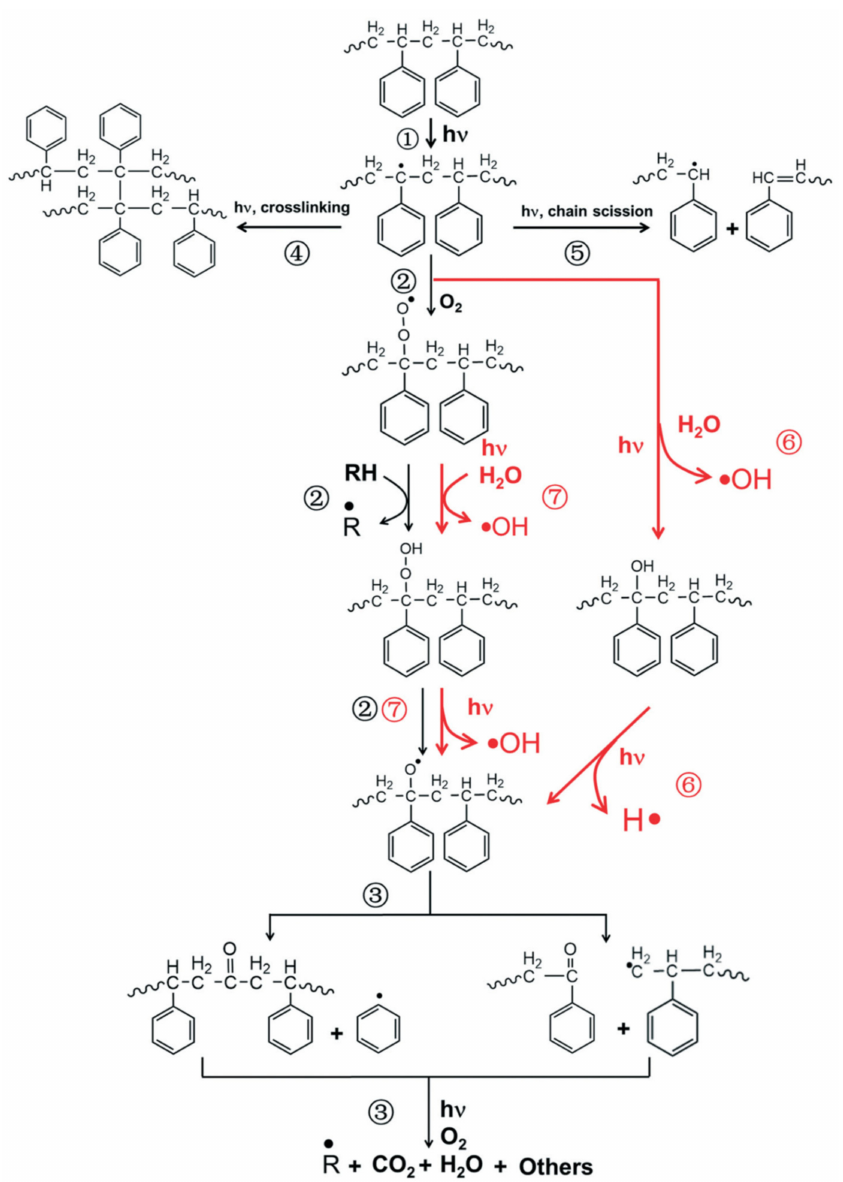
Figure 3. Proposed pathway of PS nanoplastics UV degradation in water (adapted from Tian et al. 2019, copyright